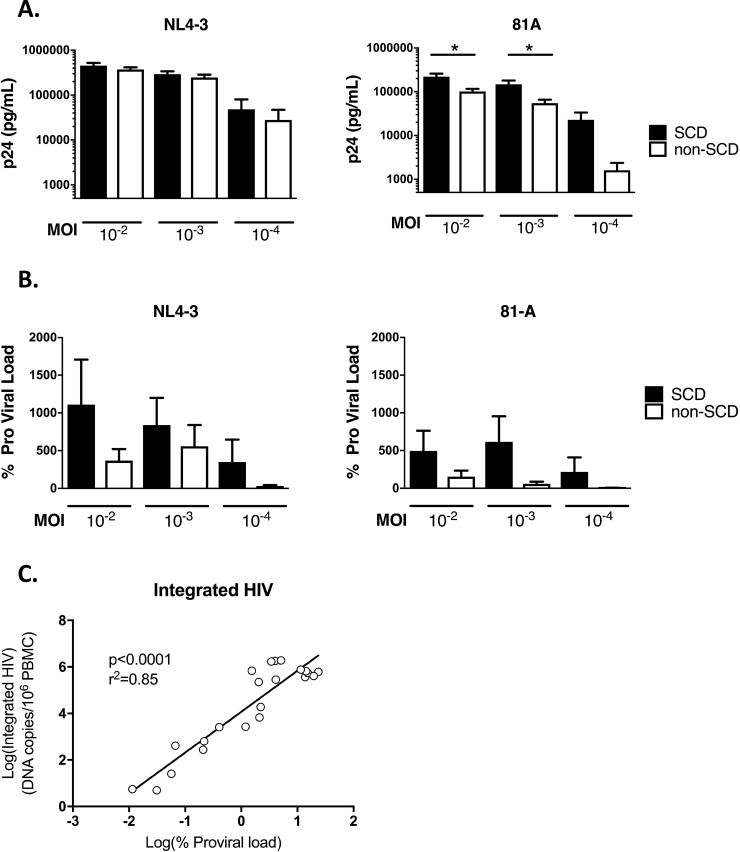
HIV Infectivity of PBMCs from SCD Patients and non-SCD Controls.CD8-depleted PBMC from SCD patients and non-SCD controls were infected with HIV NL4-3 (CXCR4-tropic) and 81-A (CCR5-tropic) at increasing MOI for six days. Following incubation, supernatants and cells were harvested for detection of HIV p24 (Panel A) and pro-viral load (Panel B) respectively. Mean and standard errors of the means for 30 SCD patients and 30 non-SCD controls are shown. Samples from four SCD patients and two non-SCD controls spanning a range of proviral load were assayed for integrated HIV DNA (Panel C). Five samples showed undetectable HIV DNA on both assays and are not graphed. The linear regression line of the log10 values is shown.